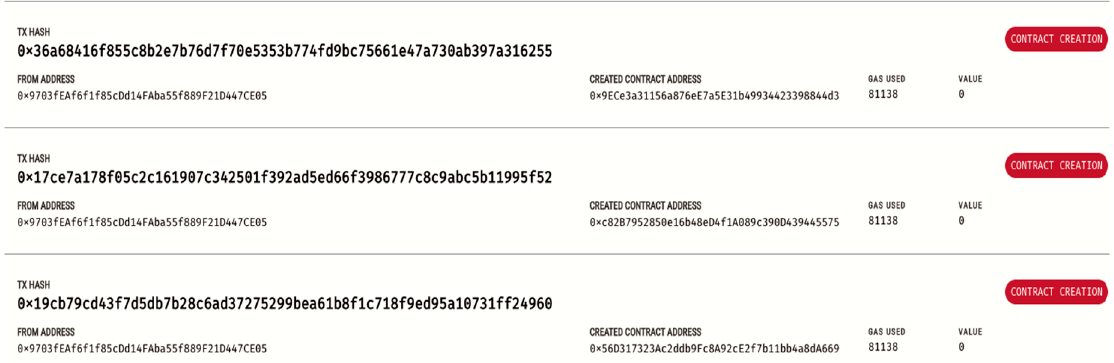
Figure 8. Transaction for company creation in Ganache.